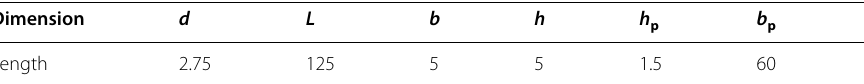
Table 5 Designed dimensions